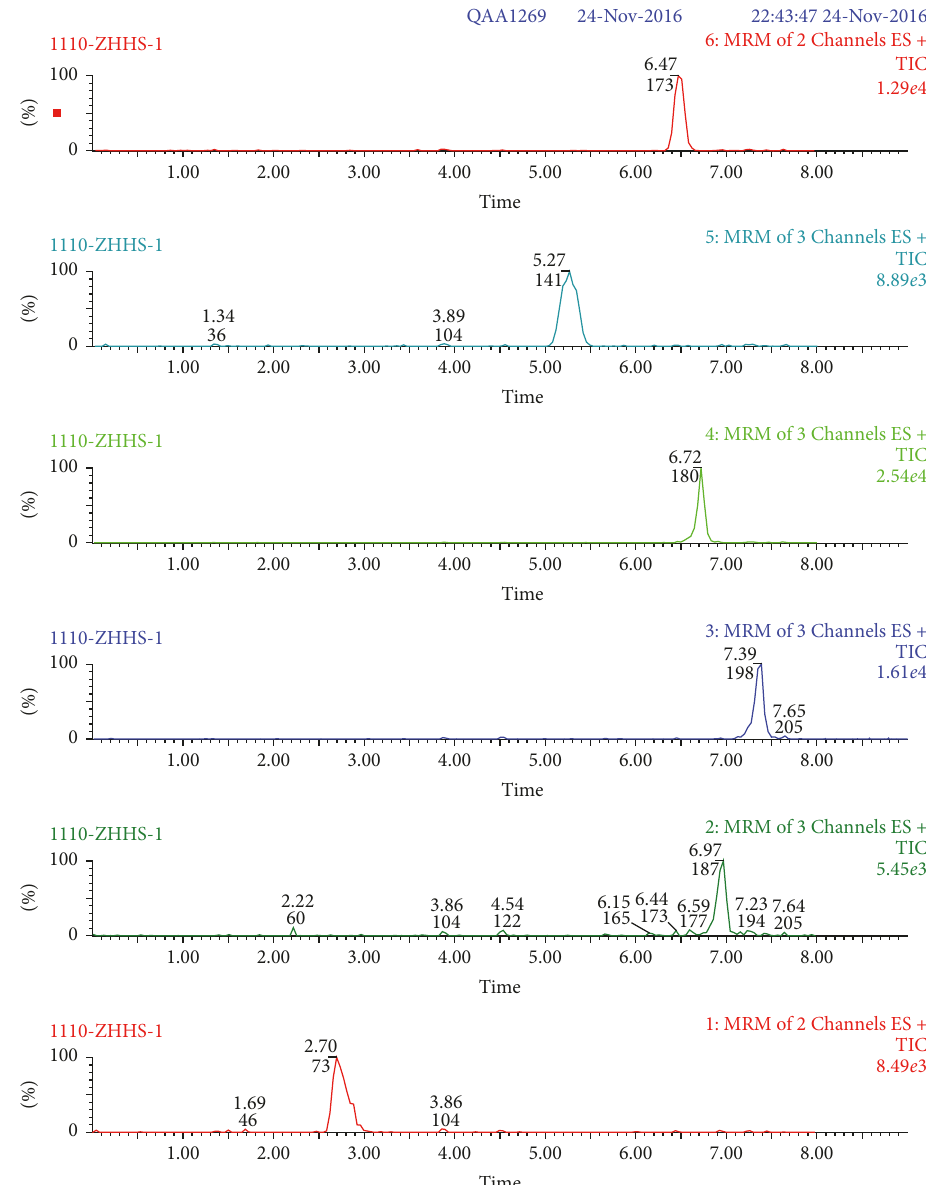
Figure 5: Typical chromatograms of MRM transitions for metronidazole, tinidazole, ornidazole, ofloxacin, ciprofloxacin, and enrofloxacin at the concentration of 25 𝜇 g/kg in jujube